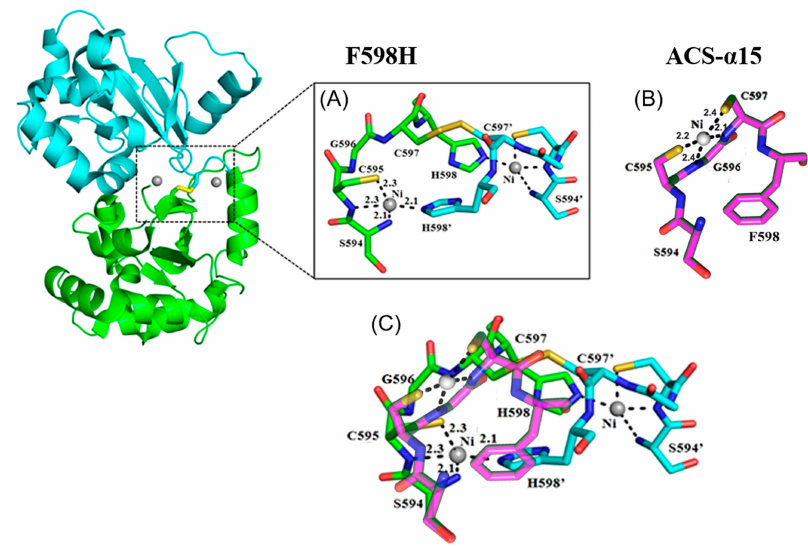
Figure 8. Overall structure of F598H (PDB: 5GOL) purified under aerobic condition and the nickel binding sites. ( A ) structure of the Ni metal center in F598H, Chain A colored by green, Chain B colored by cyan; ( B ) Ni metal center in ACS- α 15 (PDB: 3S2X), colored by purple; ( C ) Superposition of F598H (green) and ACS- α 15 (purple). Ni in grey, S in yellow, O in red and N in